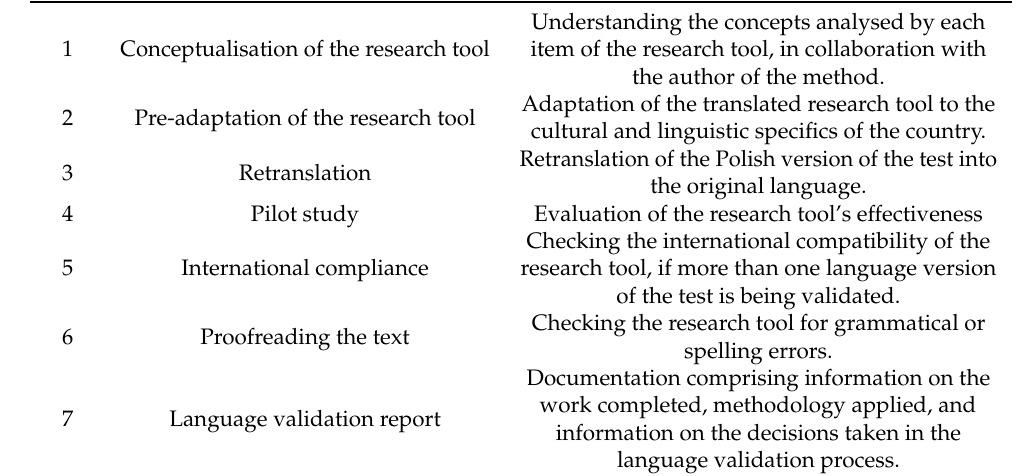
Table 1. Table addressing the Polish linguistic validation process and the international adaptation of the FES-I tool with the aid of MAPI Validation for Clinical Trial Translation